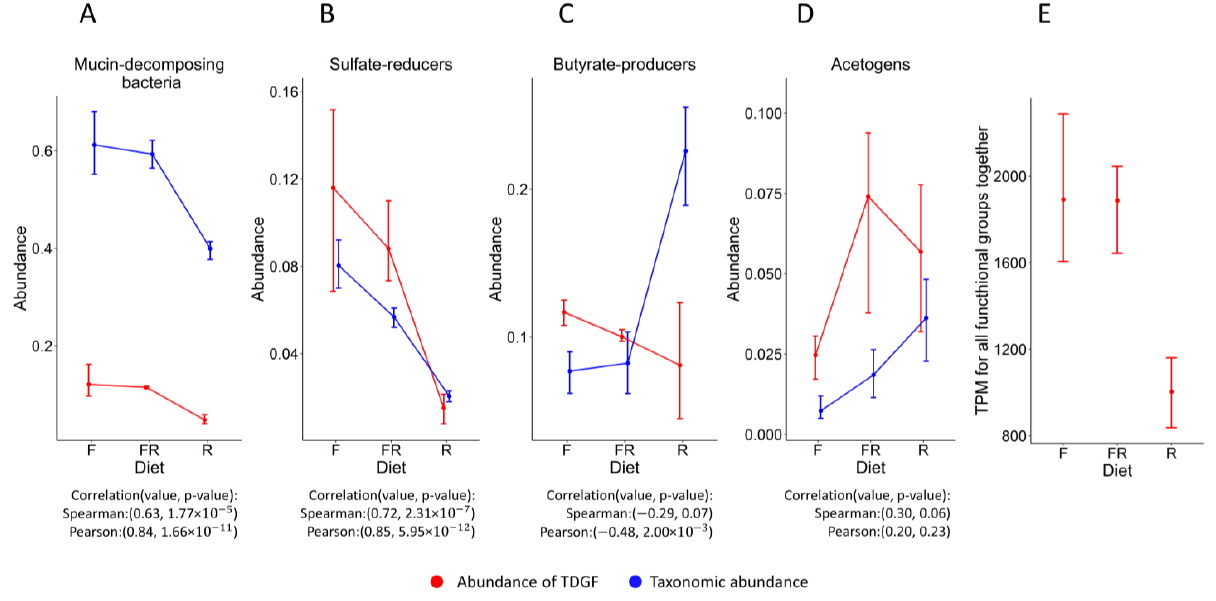
Figure 2. Comparison of the abundance of taxonomic groups. F—fiber-free diet, R—fiber-rich diet, FR—alteration between fiber-free and fiber-rich diets. ( A – D )—Comparison of TPM values calculated based on RNA-seq data and relative abundance of functional groups based on 16S rRNA sequencing data. TPM values are reduced by 5000 times for the ease of visualization in one figure. The correlation between the abundance estimated by two different methods is calculated. ( E )—total TPM value for all TDGFs together for different types of diets.